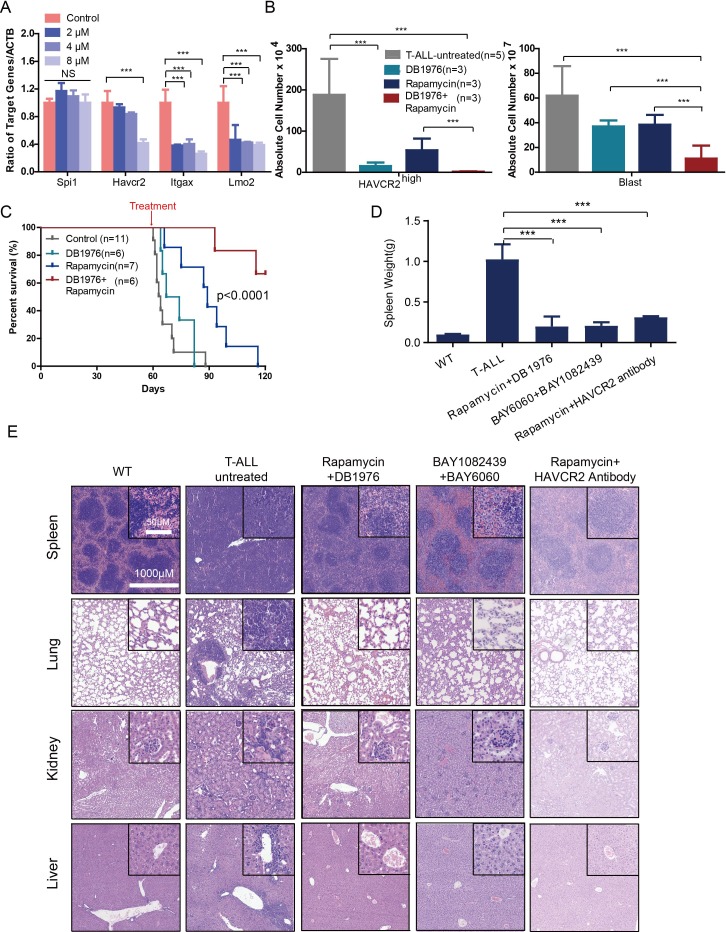
Cotargeting oncogenic driver mutations and the LSC ‘stemness’ maintenance circuit eliminated LSC and T-ALL cells(A) q-PCR analysis of Spi1 and Spi1-regulated Havcr2, Itgax and Lmo2 expression after 24 hr of DB1976 treatment (blue bars). The data are normalized to that of the untreated controls (red bars); (B) A comparison of the absolute number of HAVCR2high and blast cells in the untreated (gray bars) and differently treated groups; (C) Survival curve of Cdh5-Cre+;PtenL/L model mice treated with DB1976 and rapamycin alone and in combination; (D) A comparison of the spleen weights of 2-month-old WT mice, untreated Cdh5-Cre+;PtenL/L mice, and combination-treated mice upon euthanasia; (E) HE-stained images of spleen, lung, kidney and liver tissue from2-month-old WT, untreated and combination-treated mice. A, B and D: the data are presented as the means ± S.Ds; ***p≤0.001; the bars in the HE images and inserts represent 1000 μM and 50 μM, respectively.